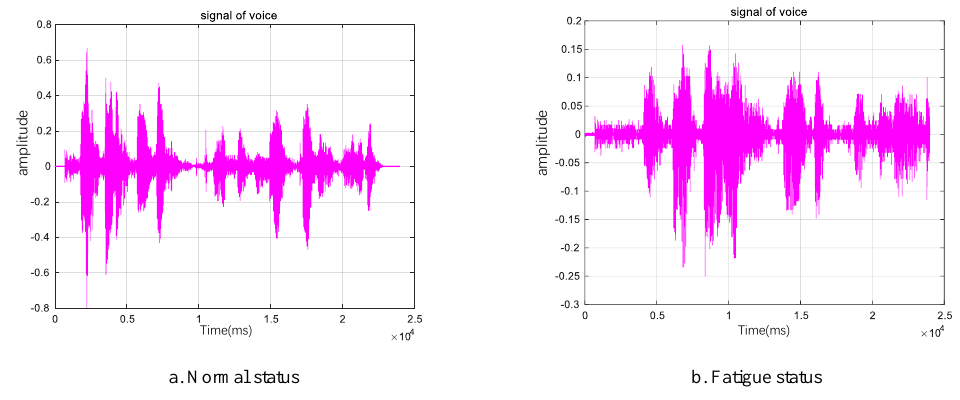
Figure 1. The signal of voice at different statuses.